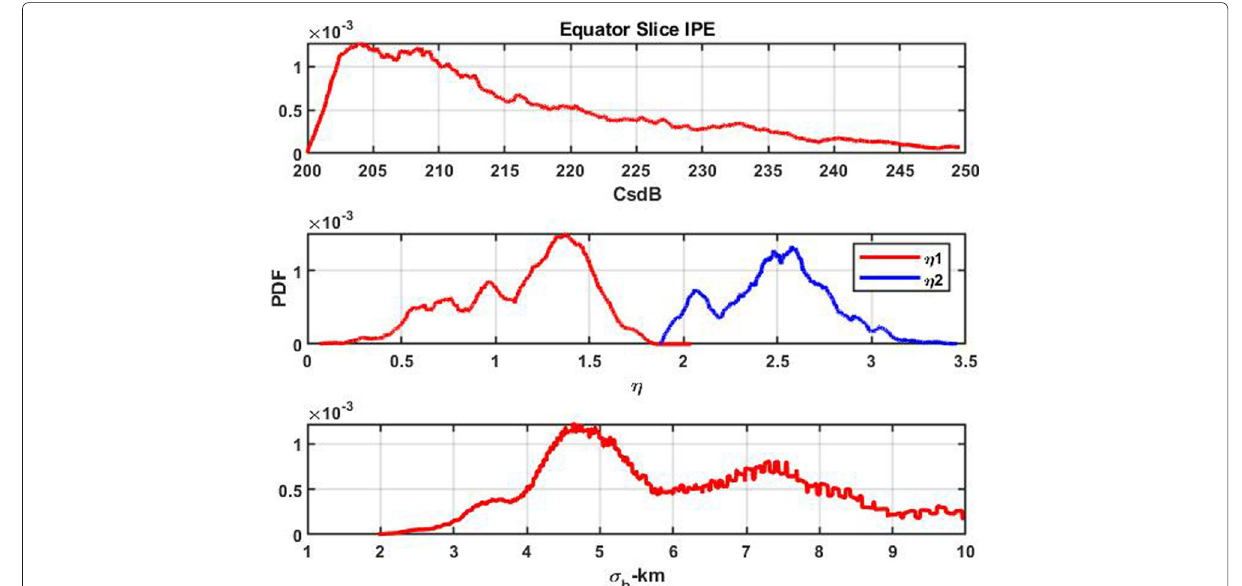
Fig. 12 Probability distributions of equatorial plane stochastic